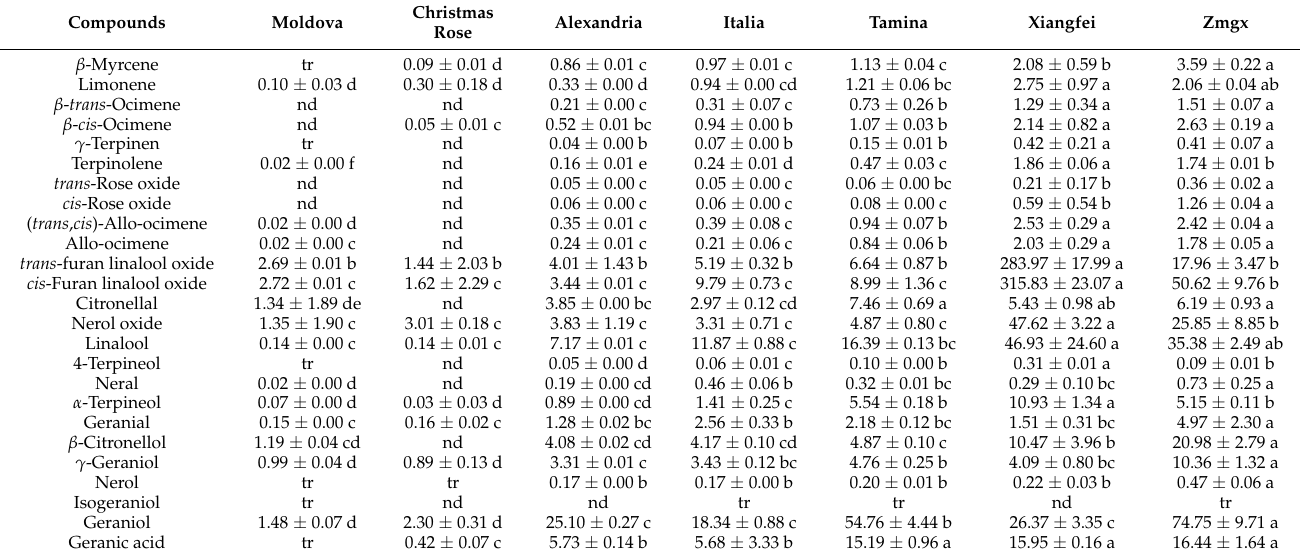
Table 1. Concentrations of monoterpenoids compounds in different table grape varieties at harvest in 2013 ( µ g/L). “nd” represented “Not detected”. “tr” represented “Trace amount”. Data were shown as means ± standard deviations of duplicate tests. Values with different letters (a–f) on a row were significantly different based on Tukey’s multiple range test ( p < 0.05). ‘Alexandria’ represented ‘Muscat of Alexandria’, ‘Zmgx’ represented